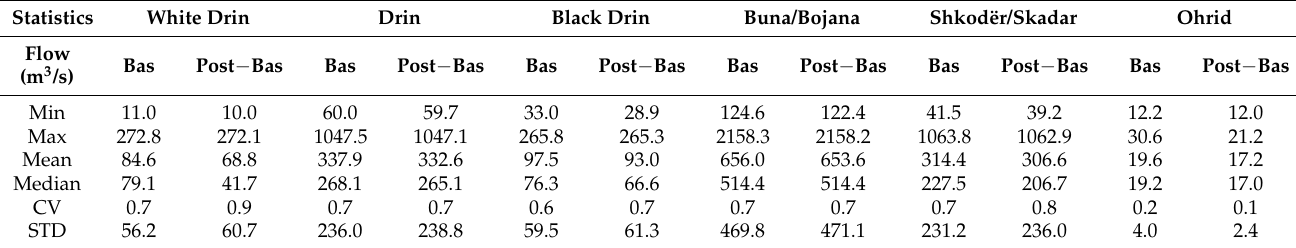
Table 3. Descriptive statistics for baseline (Bas) and post − baseline (Post − bas) streamflow conditions derived from simulated monthly time series from the PANTA RHEI